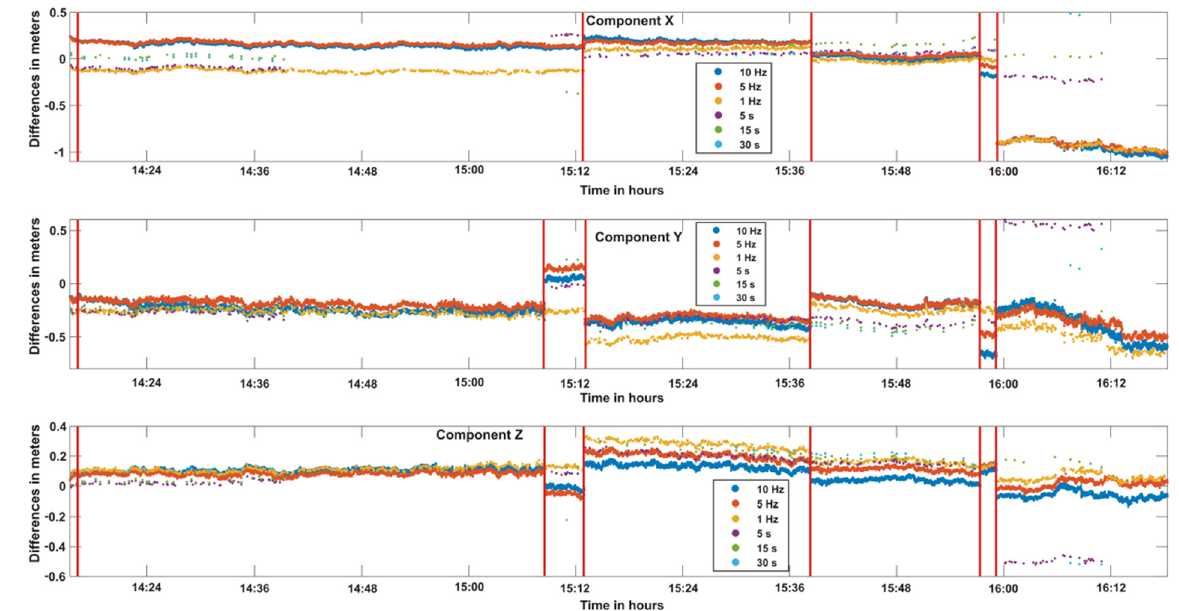
Figure 17. Convergence time achieved for solutions of the PPP method in kinematic mode.